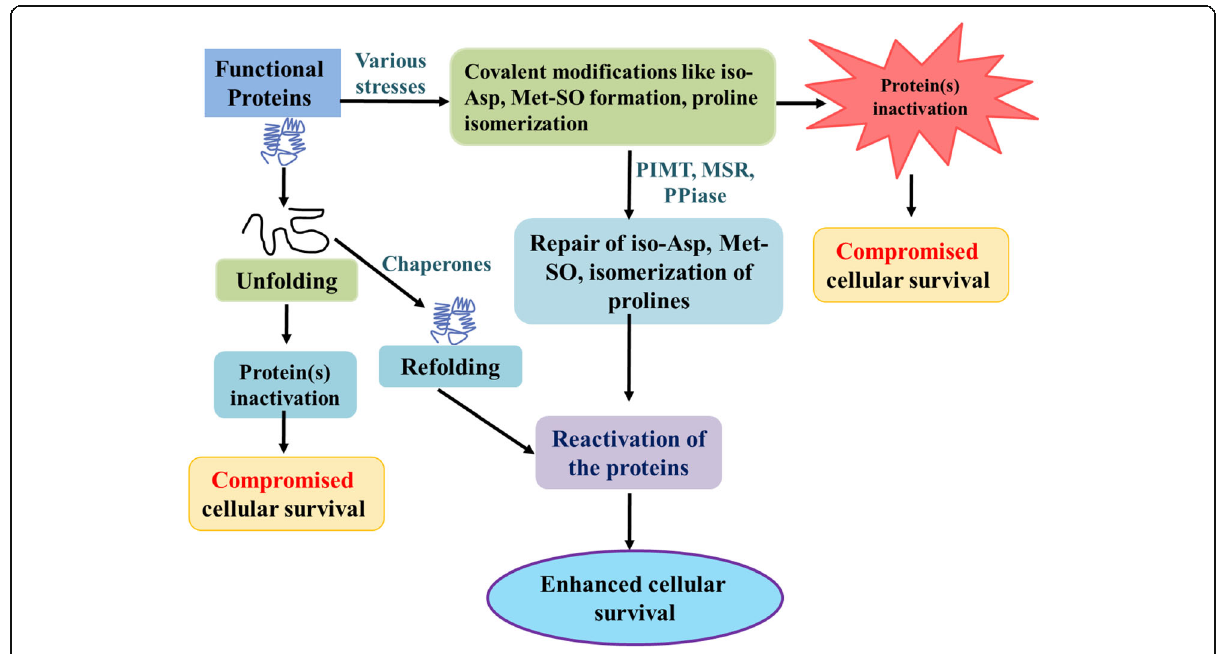
Fig. 5 Model: Different stresses cause unfolding and covalent modifications in polypeptide chain resulting in protein inactivation and consequently affect cellular survival. Chaperones can refold unfolded proteins. Protein repair enzymes (PIMT, MSR, and PPIase) can repair covalently modified amino acids. The repair of damaged proteins not only restores their functions but also enhance cellular survival